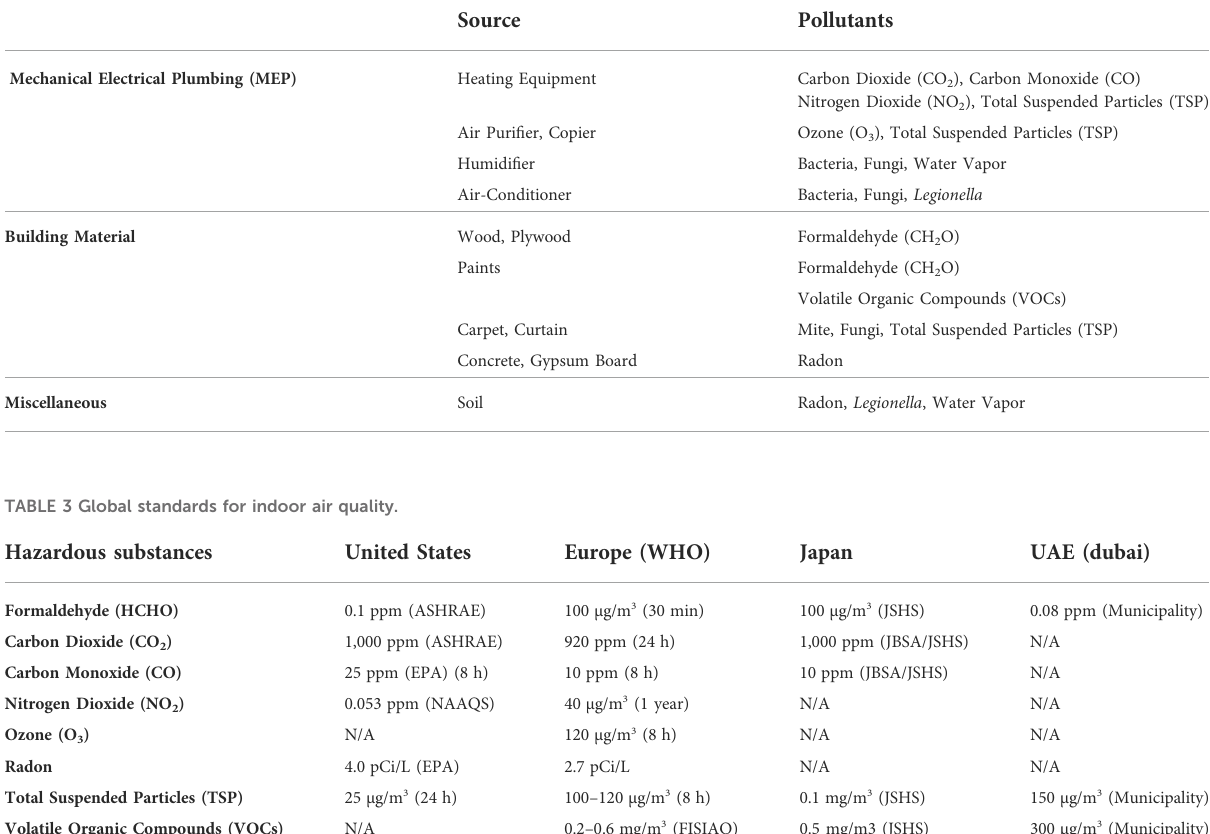
TABLE 2 Hazardous substances source and pollutants.